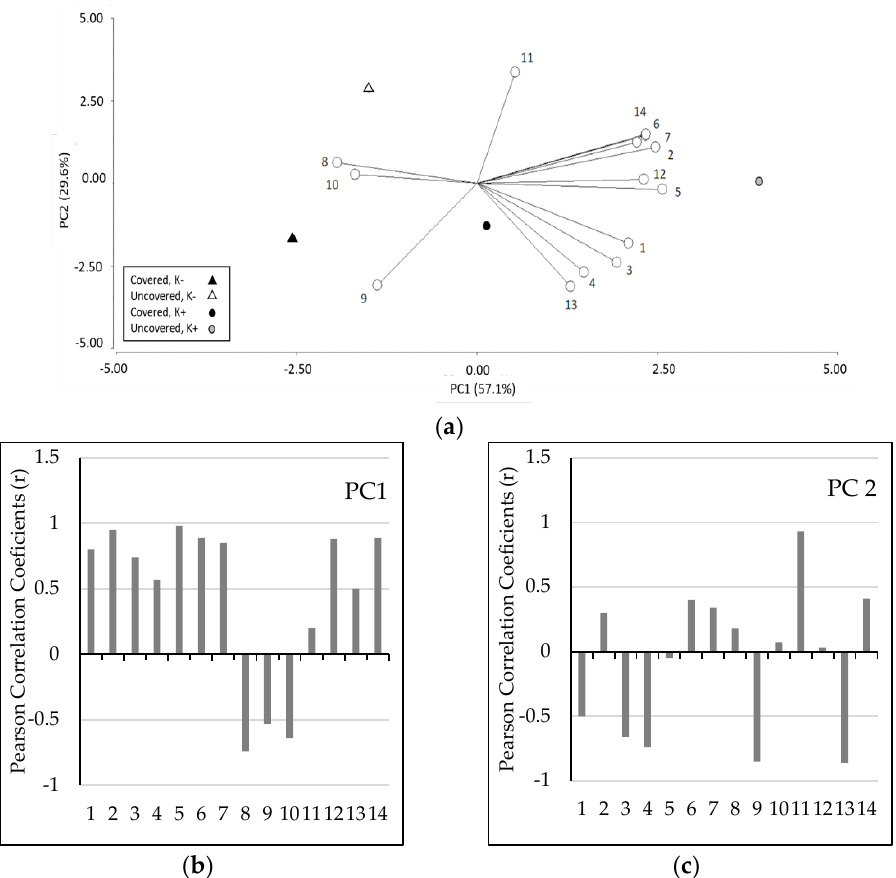
Figure 3. Principal component analysis (PCA): ( a ) scatter plot of principal component 1 against principal component 2 and loading plots of PC1 ( b ) and PC2 ( c ), representing the quality parameter, antioxidant activity, phenolic content, and concentration of phenolic and organic acids in fruits of sweet cherry cultivated in a commercial orchard of southern Chile, subjected to different cover and k treatments. Fruits from both covered and uncovered trees subjected to two foliar conventional K regime (4 sprays during the season: K- treatment) or intensive K regime (7 sprays during the season: K+ treatment) were evaluated. The white points in the scatter plot are total anthocyanins (1), total flavonols (2), total hydroxycinnamic acids (3), total phenols (4), antioxidant activity (using DDPH) (5), antioxidant activity (using ABTS) (6), oxalic acid (7), malic acid (8), citric acid (9), total OA (10), titratable acidity (11), total solid soluble content (12), maturity index (13), and firmness (14). The results of tartaric acid were excluded due to the fact that this OA was detected only in fruits from uncovered trees.